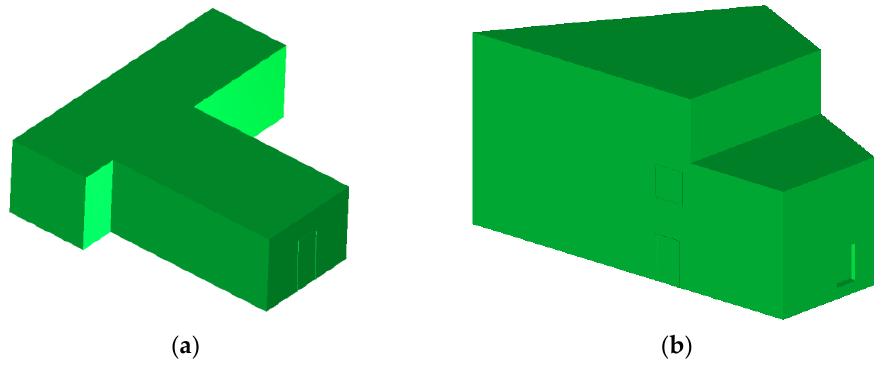
Figure 13 . Visualization of models for ( a ) dataset A1 and ( b ) dataset A2 . Figure 13. Visualization of models for ( a ) dataset A1 and ( b ) dataset